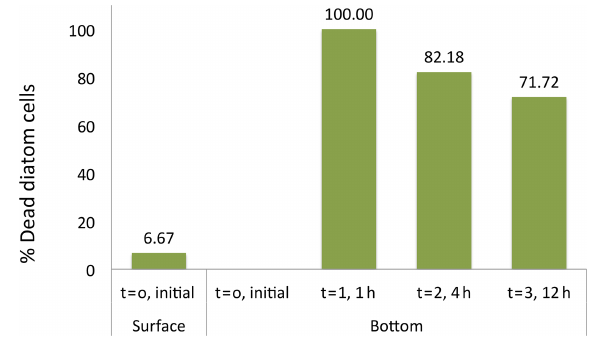
Figure 6. Diatom cell viability among the sinking cells. The initial percentage of dead cells correspond to the fresh photic-zone Arctic microplankton sample (see Methods) and added to the surface of the sinking column (1.35m height) at time 0. The percentages of dead cells at the bottom of the sinking column were collected at intervals times of 0, 1, 4 and 12h after sample inoculum